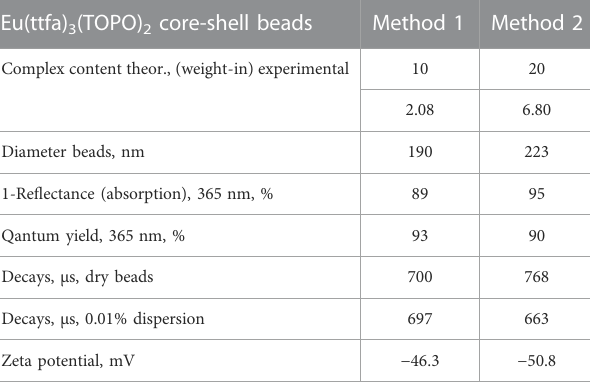
TABLE 2 Properties of carboxylated core-shell beads.